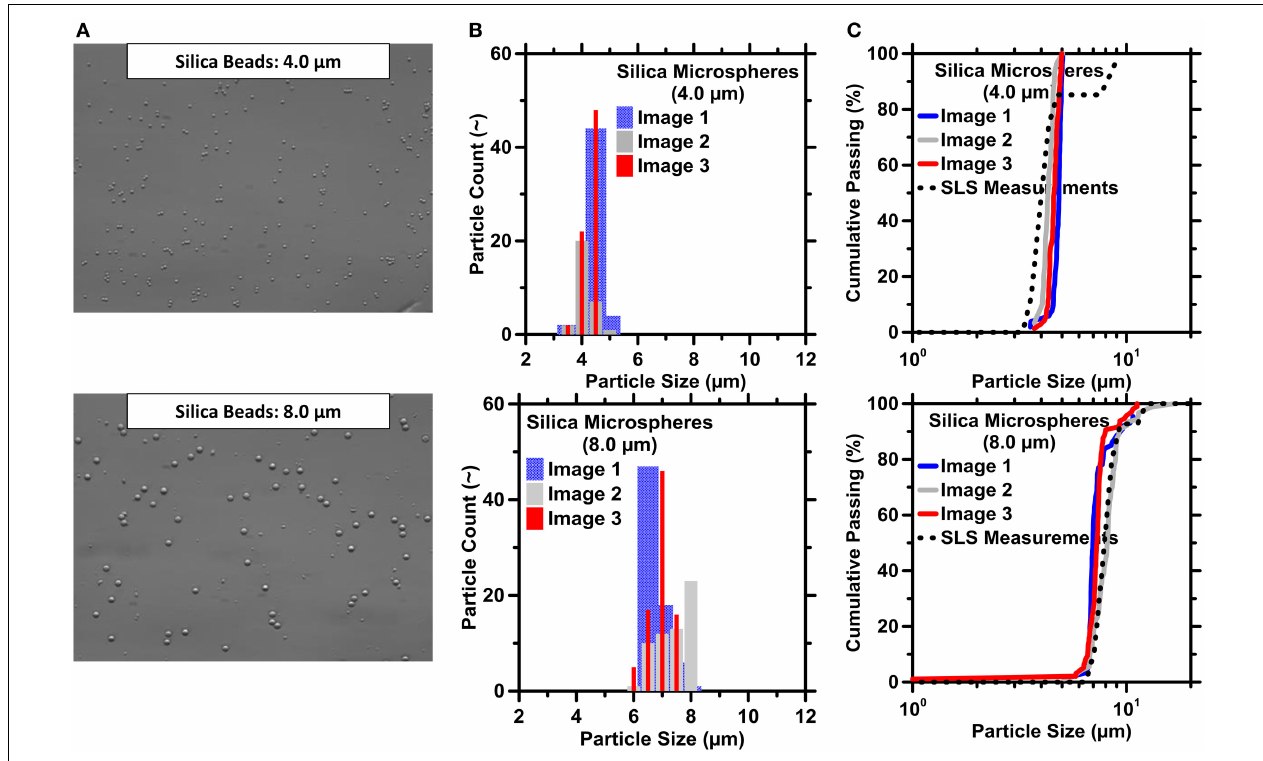
volume-equivalent spherical diameter of the particles. The highest uncertainty in particle count based on replicate ICA is on the order of 8.7%. The uncertainty in particle size based on variations in the d 50 of replicate images is in the order of 13.5%.